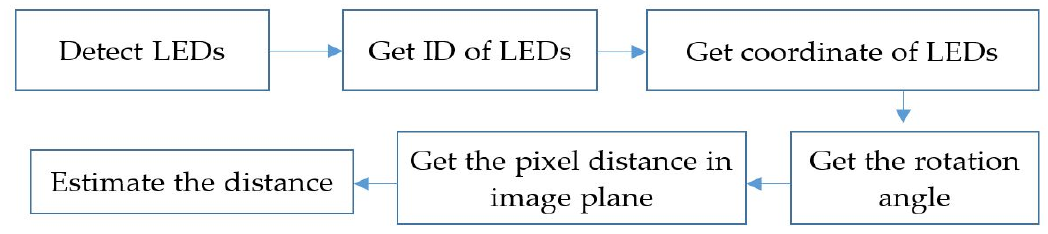
Figure 13. Distance estimation processes.